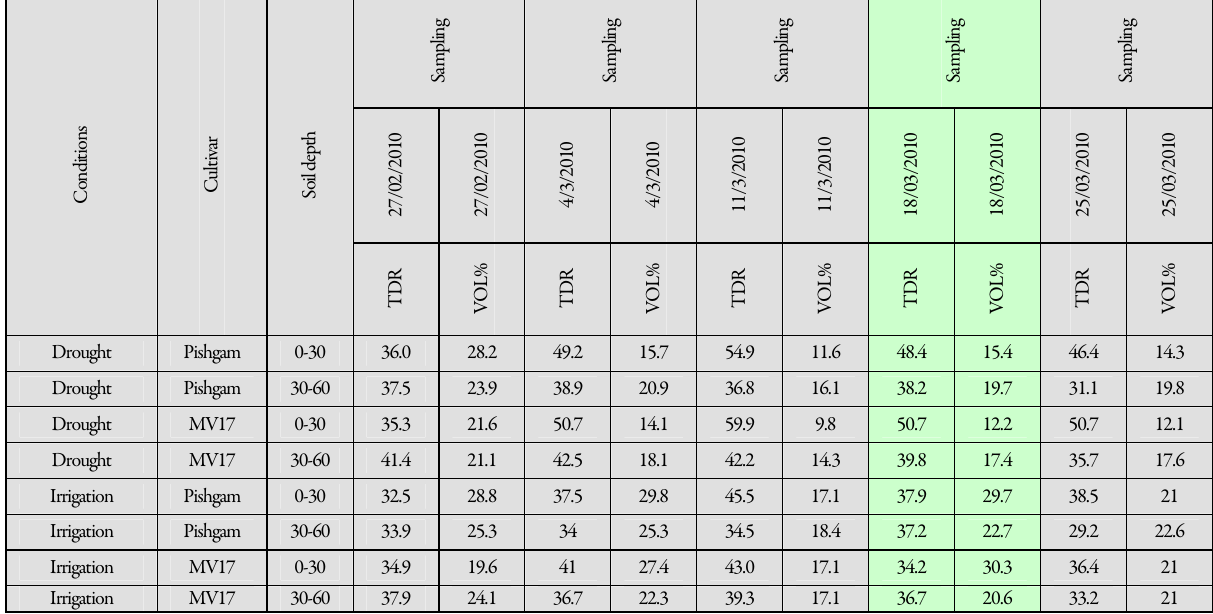
Tab. 3. Measurement of soil moisture as sampling in 0-30 cm and 30-60 cm